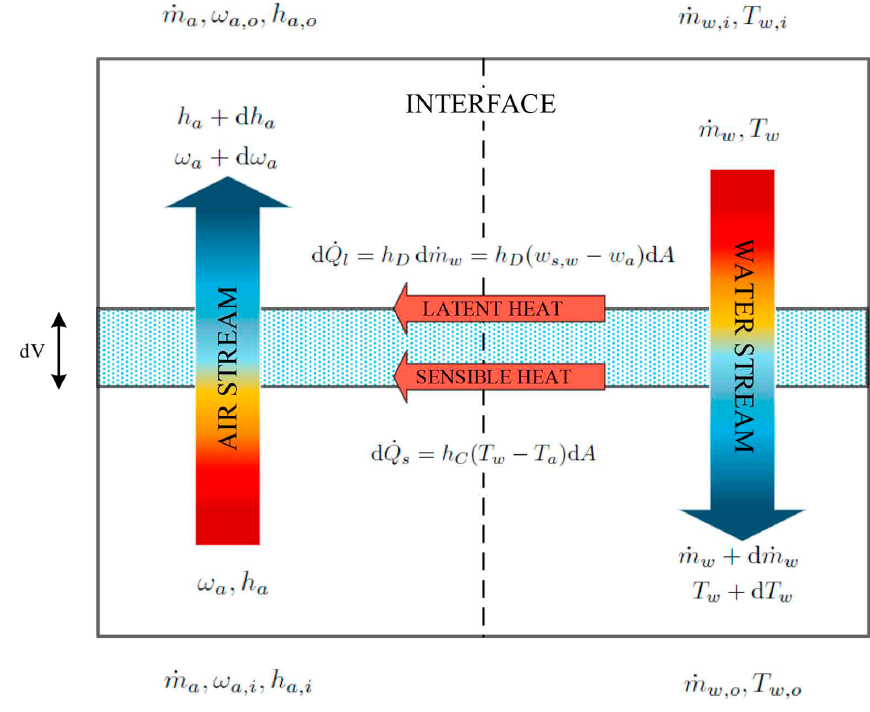
Figure 2. Schematic of a counterflow cooling